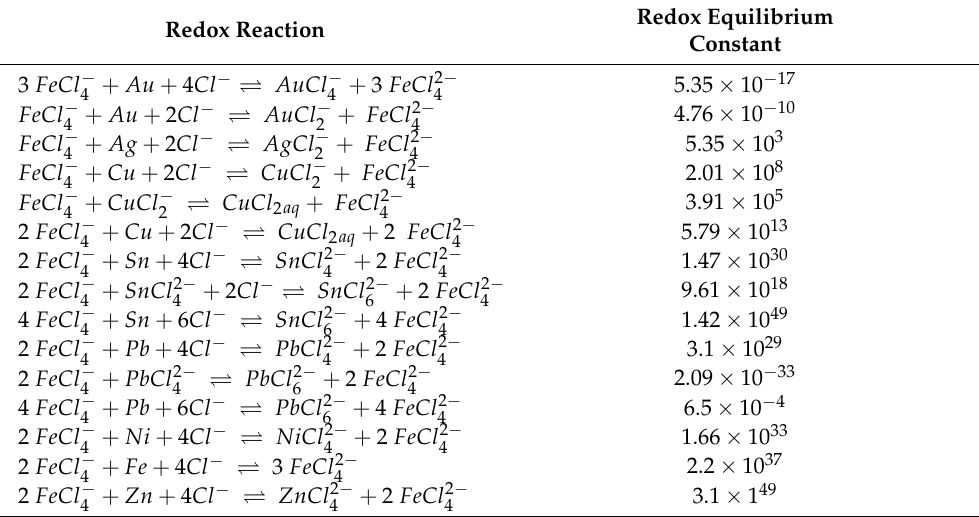
Table 5. The values of redox equilibrium constants calculated for the leaching reactions. Redox